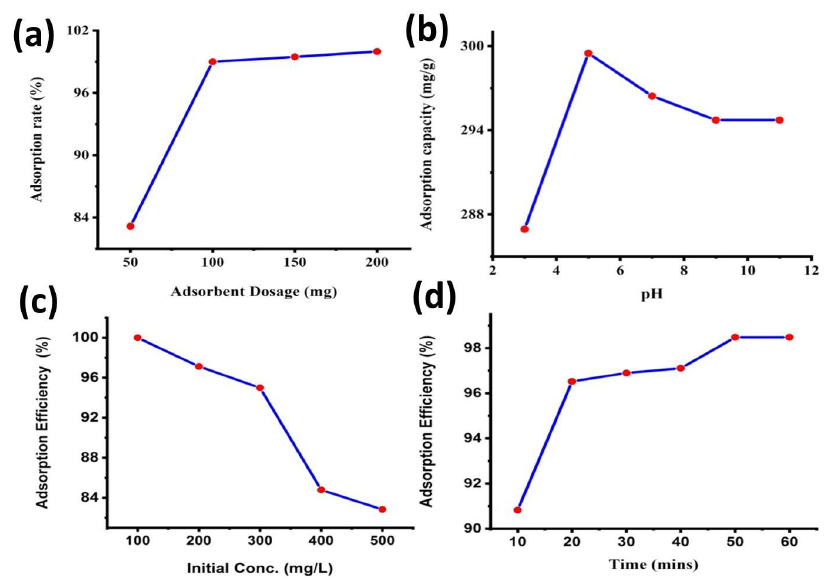
Figure 5. Effect of parameters on MB sorption, effect of adsorbent dosage ( a ), effect of pH ( b ), effect of initial conc. ( c ), and effect of contact time ( d ).